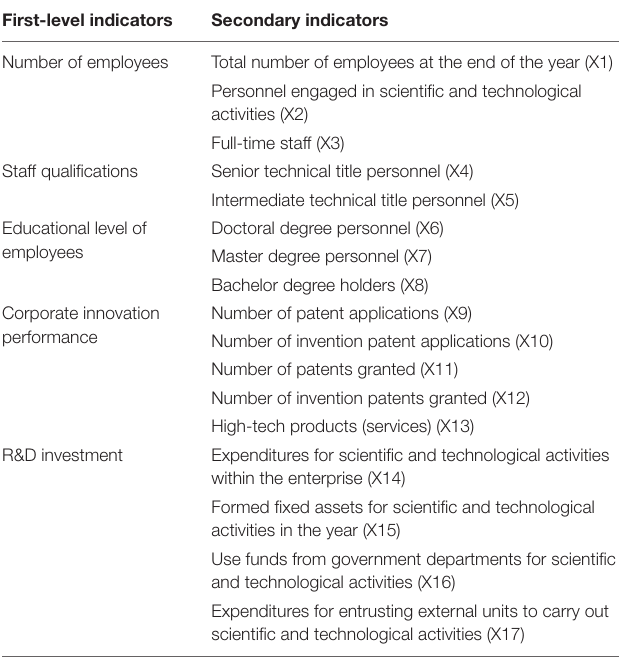
TABLE 2 | Selecting the index classification of measurement and